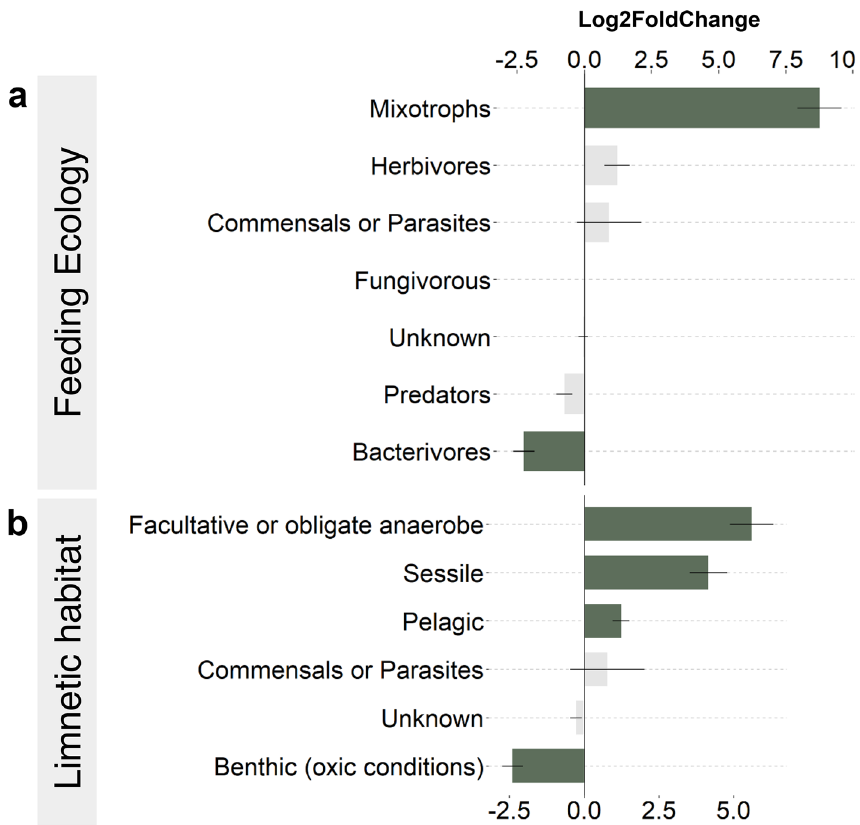
Figure 5. Amplitude of change in the functional groups between the recent and past samples according to ( a ) the feeding ecology and ( b ) limnetic habitat preferences. Magnitude of change is expressed in log2 fold change, as estimated by the DESeq2 analysis (n = 48 lakes). Dark green bars represent groups for which the change was found significant according to the two-sided Wald test corrected with the Benjamini and Hochberg method (p-value < 0.05), while the light grey bars represent groups for which the change was not significant. Horizontal lines show the standard